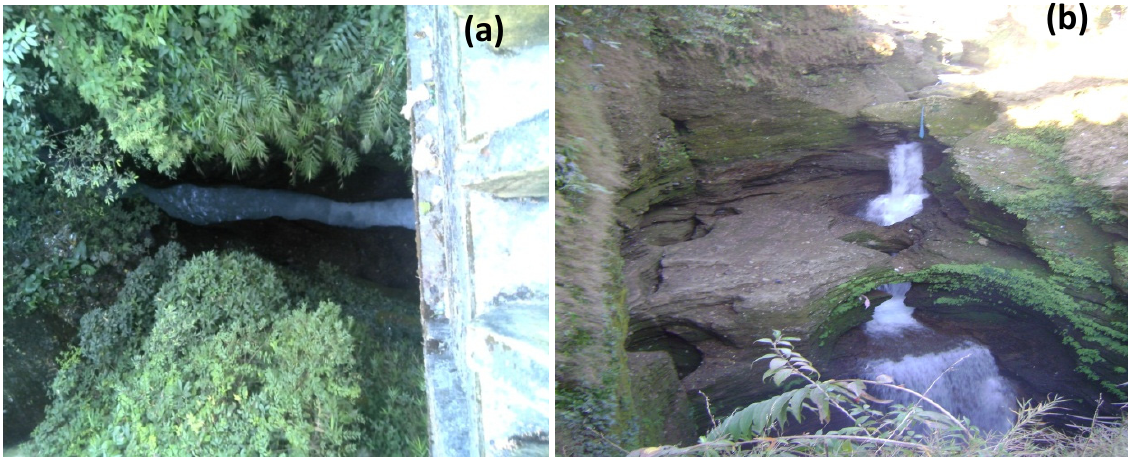
Figure 6. ( a ) Seti Gorge 2014 and ( b ) Devis’s Fall